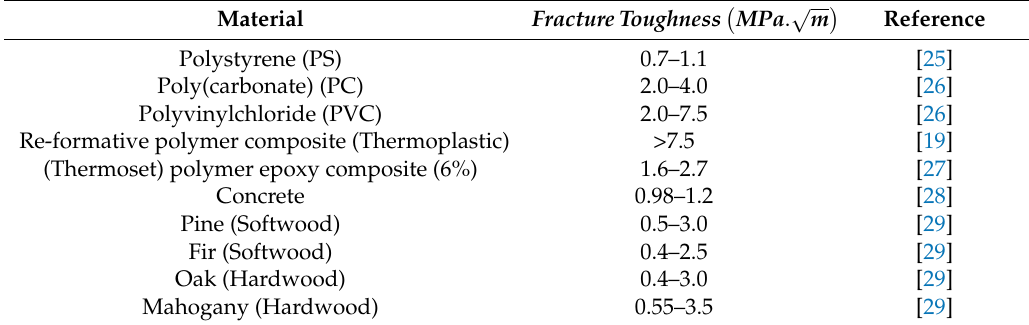
Table 2. Fracture toughness values for different